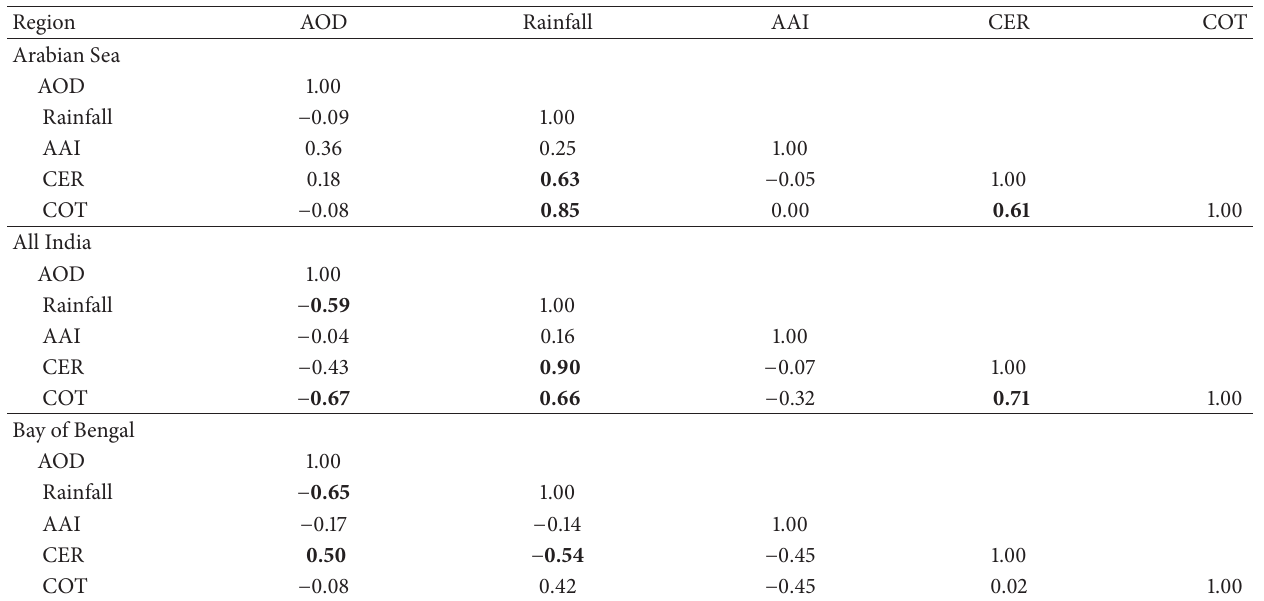
a positive correlation between rainfall and AAI indicates that either the near surface aerosols are removed less efficiently or the aerosols could be of scattering type. 2010) (Tables 2 and 3) shows that CER and COT exhibit a negative correlation with AOD over India. This feature is different over the Arabian Sea and the Bay of